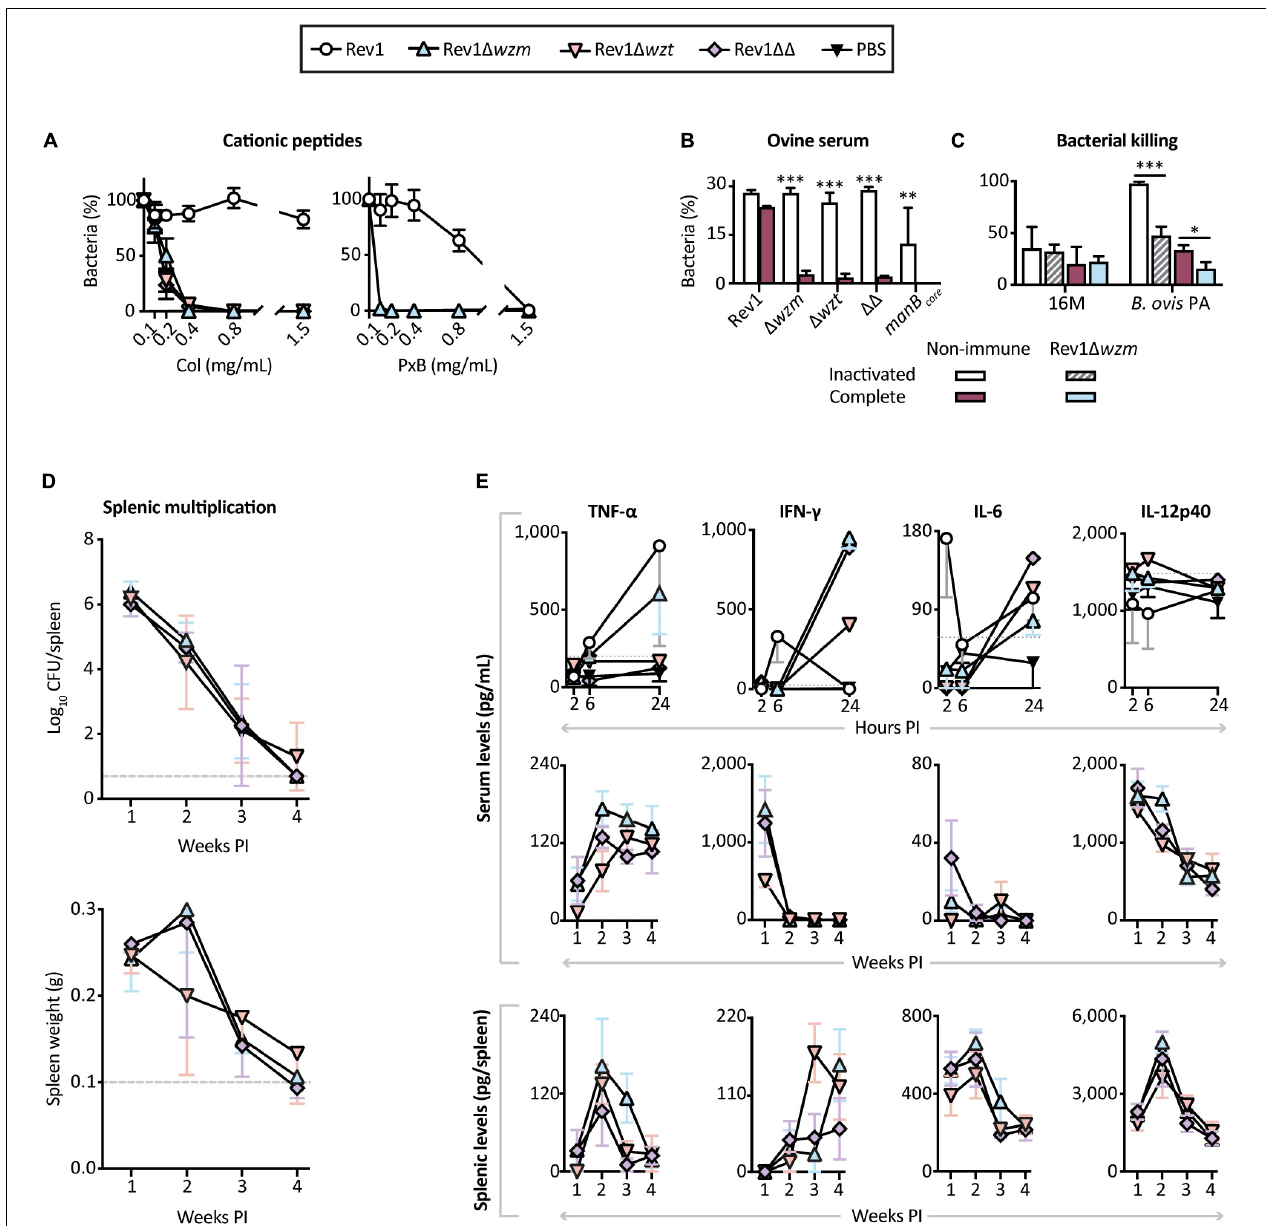
FIGURE 5 | Rev1 (cid:49) wzm is highly attenuated and triggers a stronger adaptive immune response than Rev1 (cid:49) wzt or Rev1 (cid:49) wzm (cid:49) wzt in the BALB/c mice. Susceptibility is shown for: (A) Polymyxin B (PxB) or colistin (Col), as models of cationic bactericidal peptides of the innate immune system (mean ± SD; n = 2); and (B) complement-mediated killing by conventional non-immune ovine serum, either complete or heat inactivated (mean ± SD; n = 2). (C) Bacterial killing activity of sera from sheep immunized with Rev1 (cid:49) wzm against B. melitensis 16M and B. ovis PA (BoPA) virulent strains (mean ± SD; n = 4). (D) Kinetics of spleen infections and weights (mean ± SD; n = 3 at 1 and 4 weeks PI, n = 4 at 2 and 3 weeks PI) of the BALB/c mice inoculated IP with 10 8 CFU/mouse of the correspondent mutant; the dashed lines indicate the detection limit (log 10 5 CFU/spleen = 0.70) and normal splenic weight (0.1 g) in the BALB/c mice. (E) Cytokine profiles in blood sera and splenocytes supernatants from the same mice at selected intervals; sera collected at 2, 6, and 24 h PI ( n = 5) were processed as pools, including two independent experiments for Rev1 (cid:49) wzm , Rev1, and PBS groups; dotted lines represent PBS’s maximum value; blood sera and splenocytes supernatants collected at 1, 2, 3, and 4 weeks PI were processed individually for each necropsied group (mean ± SEM). Fisher’s LSD test; ∗∗∗ p ≤ 0.001, ∗∗ p ≤ 0.01, ∗ p ≤ 0.05 immune vs. non-immune sera for a given strain.